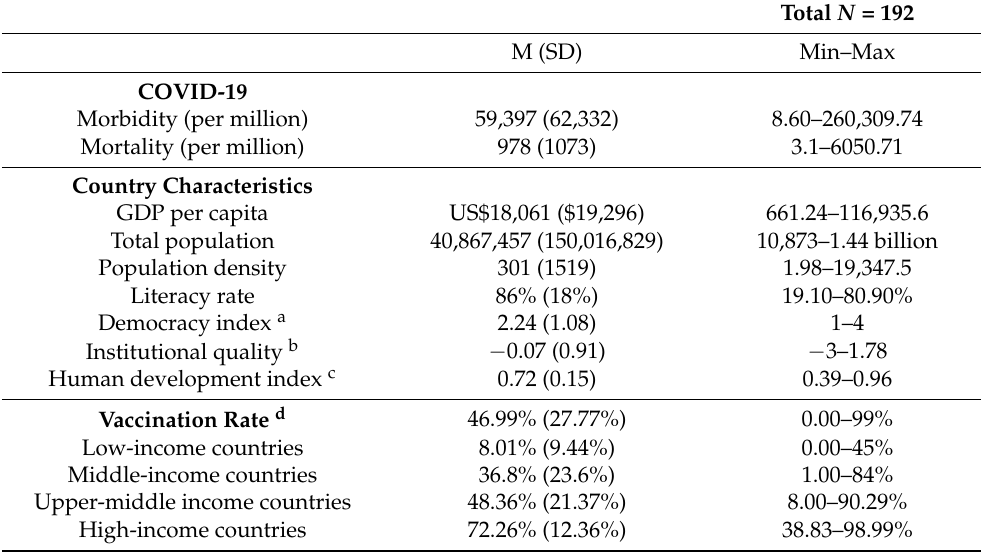
Table 1. Description of